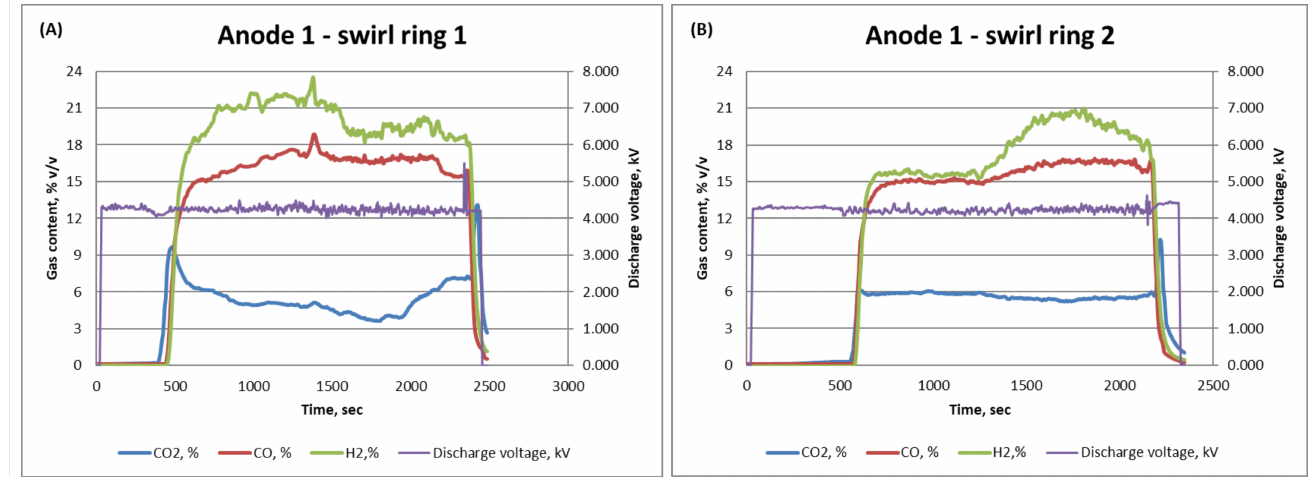
Figure 9. Comparison between Ring 1 ( A ) and Ring 2 ( B ) with Anode 1.